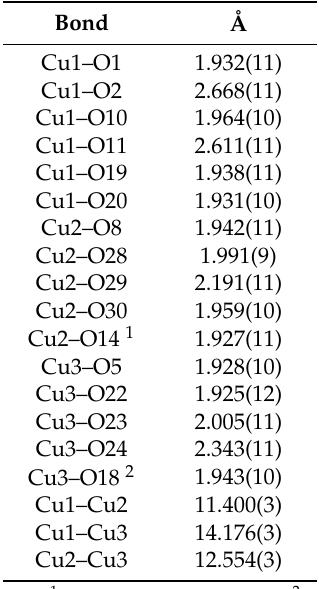
Table 1. Selected bond lengths (Å) for 1